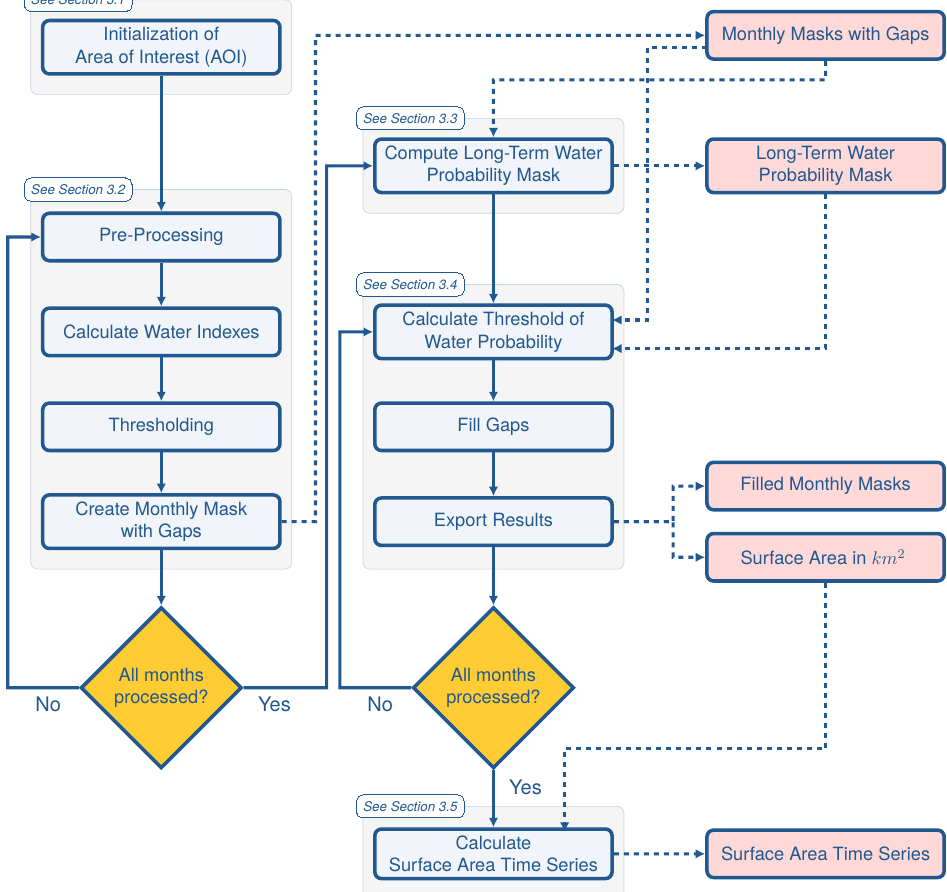
Figure 2. Flowchart of the AWAX with processing steps (blue) and resulting data sets